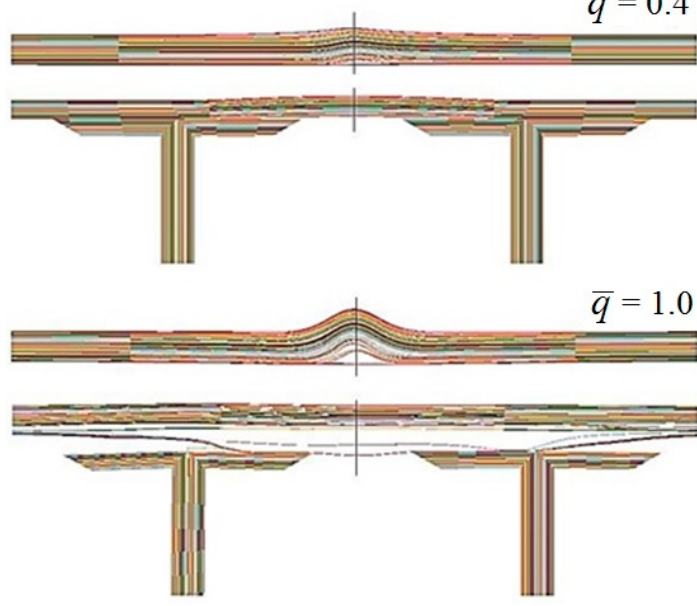
Figure 8. Post-buckling deformations of the panel in the transversal and longitudinal directions near the damage area.